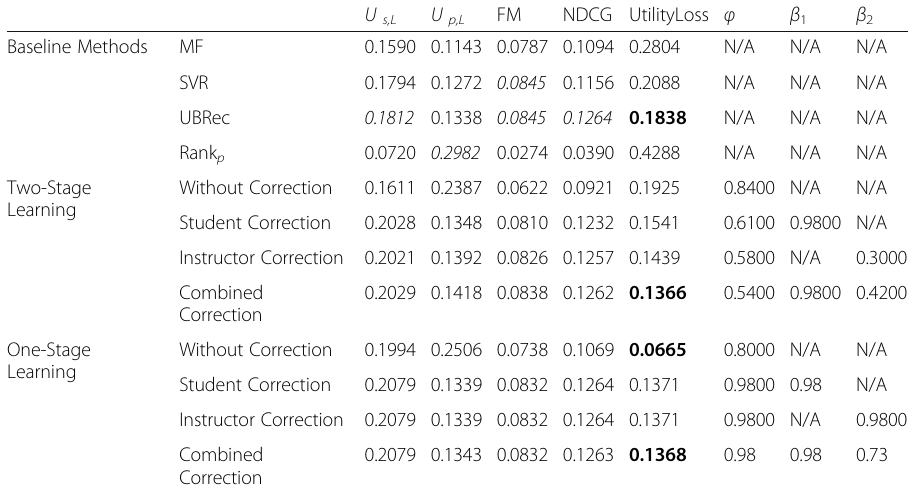
Table 2 Experimental